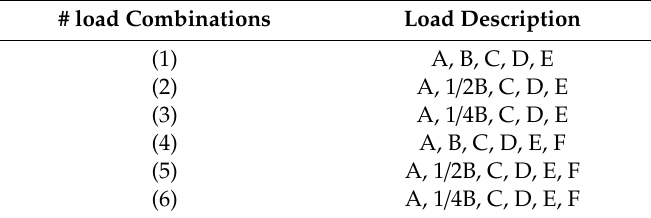
Table 3. Additional load combinations applied for the analyzed masonry arch